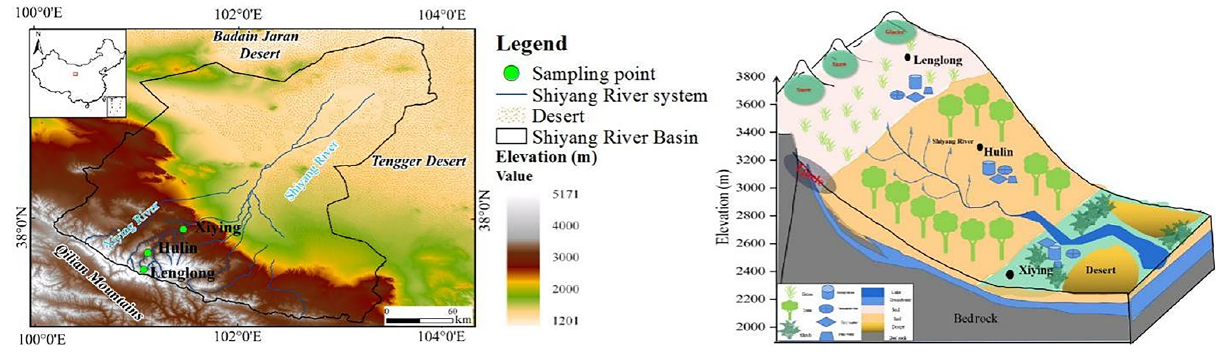
Figure 1. Study area and observation system. Table 1. Basic information table of sampling